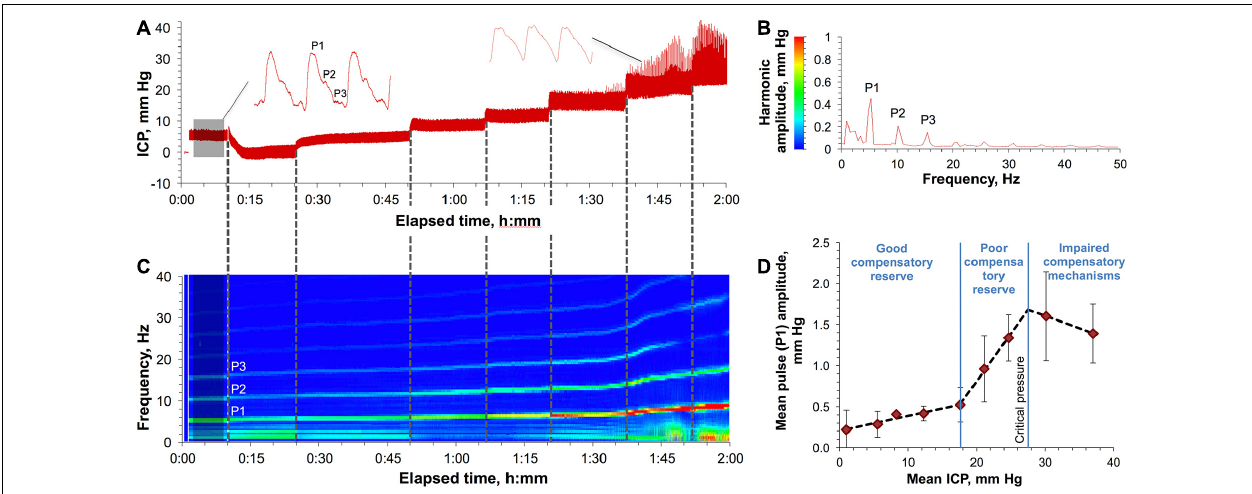
FIGURE 1 | Characteristics of ICP elevation in a rat. (A) Various ICPs induced by a saline column attached to the rat’s CSF in the cisterna magna. Shaded area indicates baseline ICP. A representative ICP pulse waveform at low and high pressures are shown in the left and right sides, respectively. P1, P2, and P3 are the major pulse’s harmonics. (B) The amplitude-frequency characteristics of the spectrally resolved P1, P2, and P3 harmonics of the baseline ICP pulses (shaded area in panel A ). A result of averaging of 2564 FFTs each consisting of 2000 points. (C) Spectrum view of the changes in the harmonics’ frequencies and amplitudes as a result of ICP elevation over time (A) . (D) ICP autoregulatory capacity and compensatory reserve in rats. Three specific zones characterizing different states of ICP compensatory reserve are shown and are based on the correlation between the mean amplitude of the P1 component of the ICP pulse and the mean ICP. Each data point represents a mean value obtained by averaging over four animals. Error bars indicate standard deviations. Least-squares linear regression is depicted for each zone with the following R 2 statistic (left to right): 0.9438, 0.9978, and 1.0000.